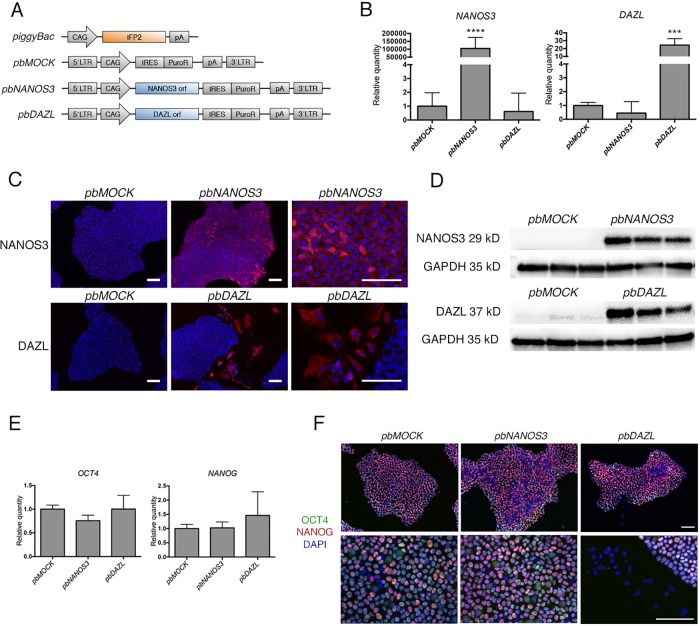
Stable over expression of NANOS3 and DAZL in hES cells.A) Schematic representation of piggyBac over expression constructs. Transposase expression vector (piggyBac) contained the IFP2 open reading frame (ORF) driven by the CAG promoter. Transposon expression vectors contained the ORF for NANOS3 (pbNANOS3) or DAZL (pbDAZL) driven by the CAG promoter, followed by IRES element and puromycin resistance gene, and flanked by the piggyBac 5’ and 3’ long terminal repeats (LTRs). Vector without ORF was used as a control (pbMOCK). Human ES cells were co-transfected with the transposase vector and one of the transposon vectors, and selected with puromycin. B) Gene expression analysis of NANOS3 and DAZL expression by qPCR. Samples from three separate transfections were used at passage 2 after transfection. Values are relative quantities normalized to GAPDH and RPLPO, and represented as mean ± SD. Statistical significance was tested by one-way ANOVA, **** p < 0.0001, *** p < 0.001. See also S1 Table. C) Immunofluorescence staining of NANOS3 (red) and DAZL (red) in pbNANOS3 and pbDAZL cells, respectively. Note the DAZL positive cells outside the colonies. pbMOCK cells were used as negative control. Cells were counterstained with DAPI (blue). Scale bar 100 μm. D) Confirmation of NANOS3 and DAZL protein expression in pbNANOS3 and pbDAZL cells by Western blotting. Samples at passage 2, 5 and 6 after transfection were used for each cell line. pbMOCK cells were used as negative control, and GAPDH was used as endogenous control for protein loading. See also S1B Fig. E) Gene expression of pluripotency markers OCT4 and NANOG in transfected cells. Samples from three separate transfections were used at passage 2 after transfection. Values are relative quantities normalized to GAPDH and RPLPO, and represented as mean ± SD. See also S1 Table. F) Immunofluorescence staining of OCT4 (green) and NANOG (red). Note the negative pbDAZL cells outside the colonies. Cells were counterstained with DAPI (blue). Scale bar: 100 μm. See also S1C Fig.